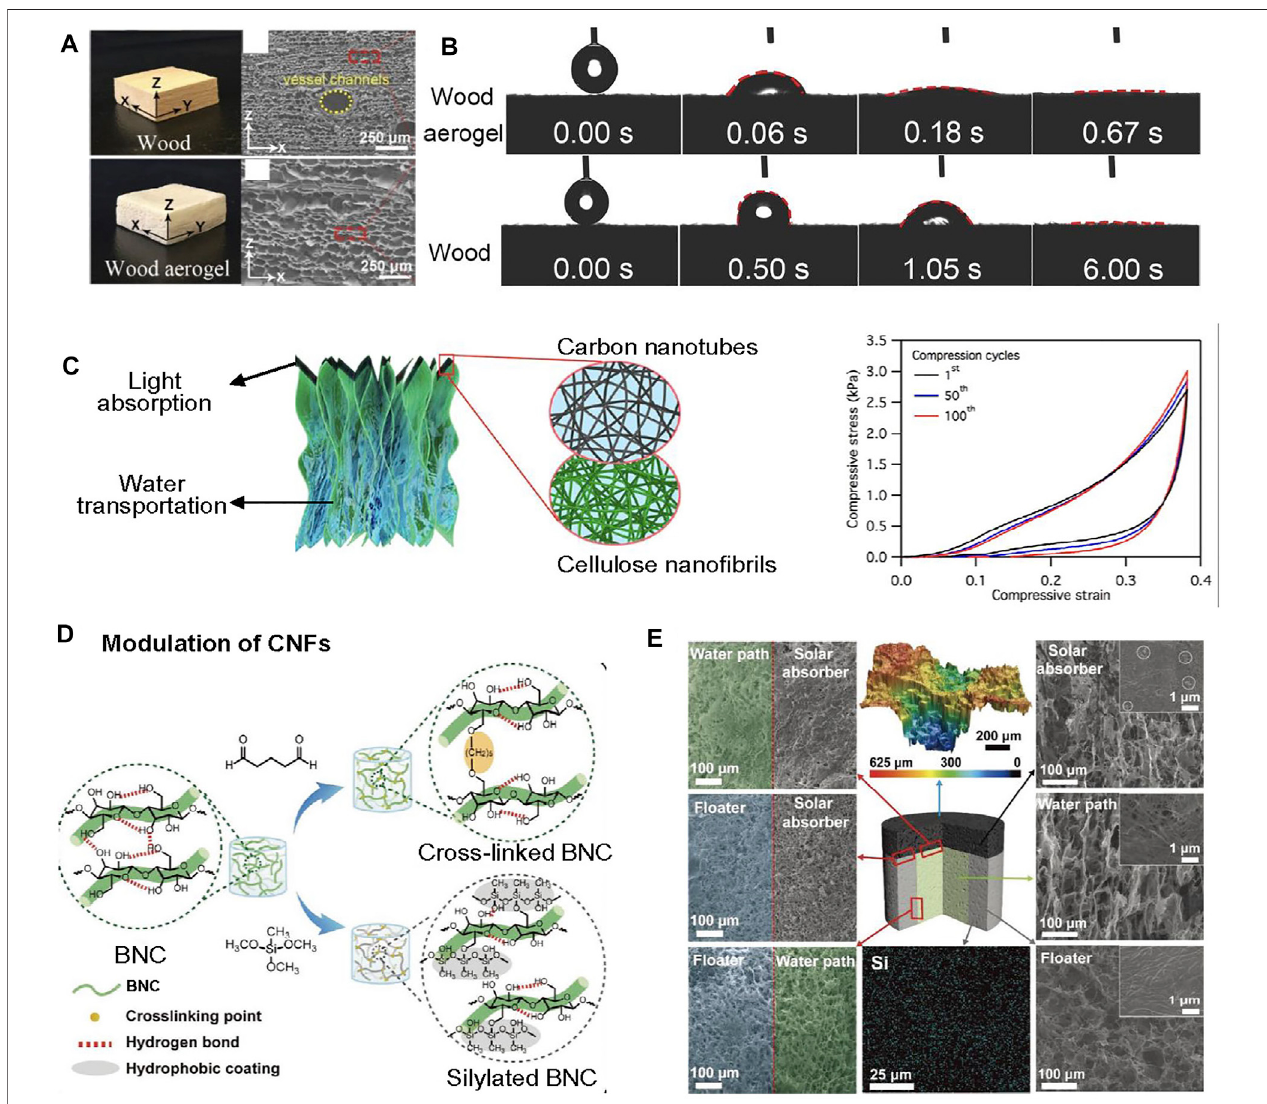
FIGURE 3 | Cellulose nano fi bers as building blocks for fi brous aerogels. (A) The photographs and corresponding SEM images of the natural balsa wood and the wood-derived aerogel. (B) Water contact angle images of wood and wood-derived aerogels in (A) when a water droplet was dropped on their surface, indicating better hydrophilicity of the wood-derived aerogels compared with that of the originalwood. Reprinted with permission from (Zhang Q. et al., 2020). Copyright (2020) American Chemical Society. (C) (left) Schematic illustration of the bilayer CNF − CNTs aerogel used for solar steam generation. The SVG device is composed of a bilayer structure of a bulk CNF aerogel with CNTs depositing on the surface. (right) The compressive cyclic test of CNF-CNTs aerogel in water demonstrates the mechanical robustnessofaerogel. Reprinted withpermissionfrom(Jiangetal.,2018).Copyright(2018) AmericanChemicalSociety. (D) Syntheticroutesandchemicalstructuresof the bilayer aerogel. (E) 3D optical microscope images and cross-sectional SEM images of each component in the bilayer aerogel. Reprinted with permission from (Li N. et al., 2021). Copyright (2020) WILEY VCH.